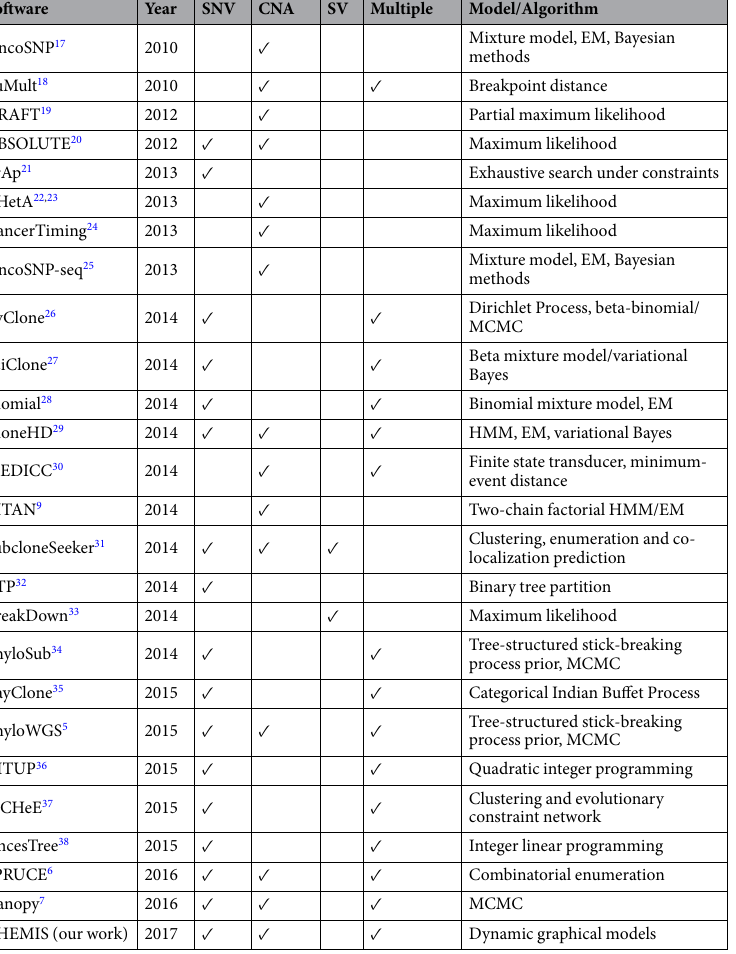
✓ Dynamic graphical models Table 1. Software tools for characterizing within-patient and intra-tumor heterogeneity and their features, including whether they capture SNVs, CNAs and structural variants (SVs), whether they support multiple biopsy analysis, and their key models and